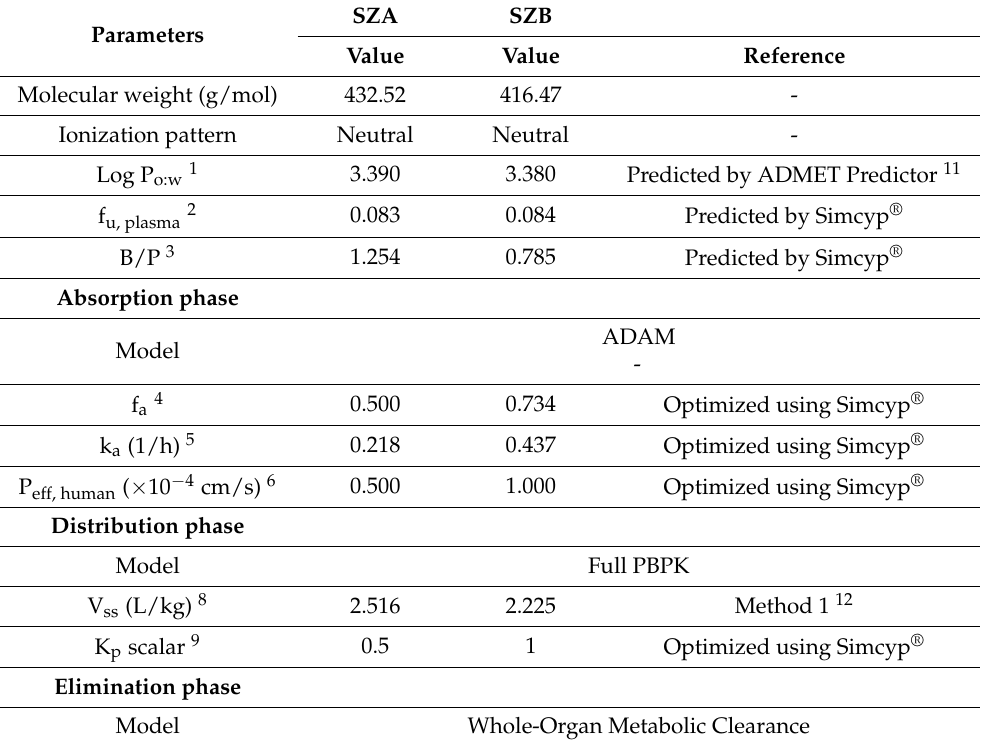
Table 3. Input parameters of PBPK